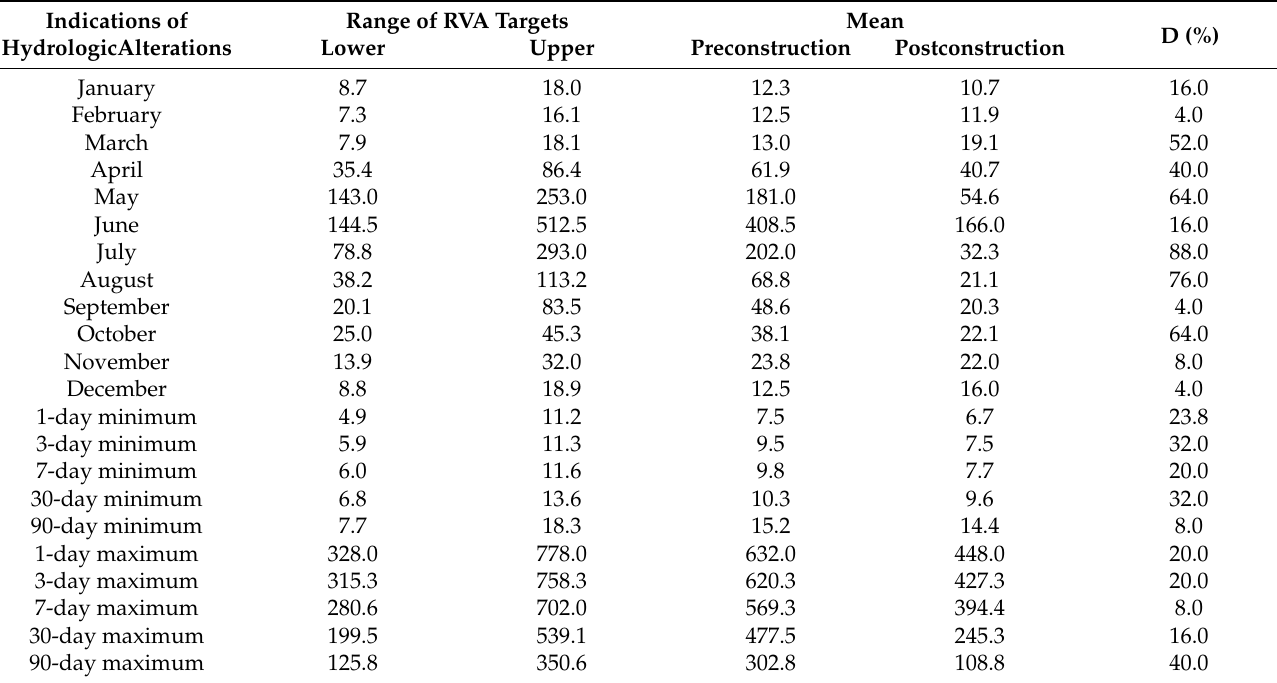
Table 1. Indicators of Hydrologic Alteration (IHA) of Burqin hydrological